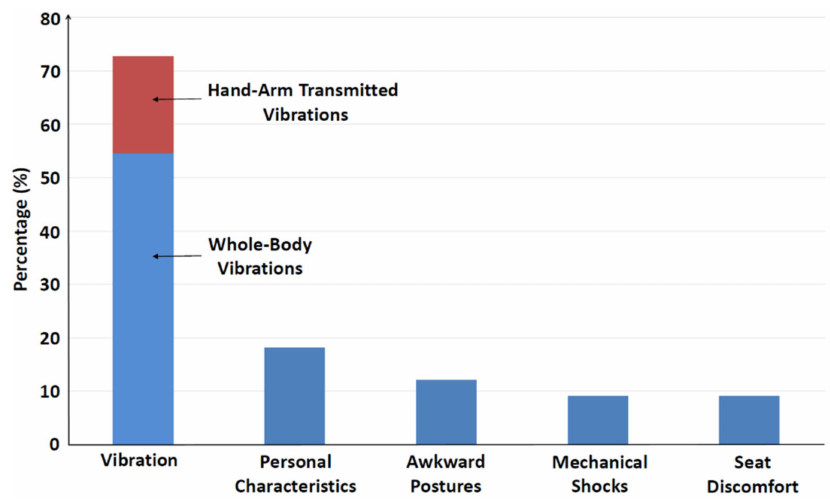
Figure 8. Percentage (%) of the main identified risk factors causing musculoskeletal